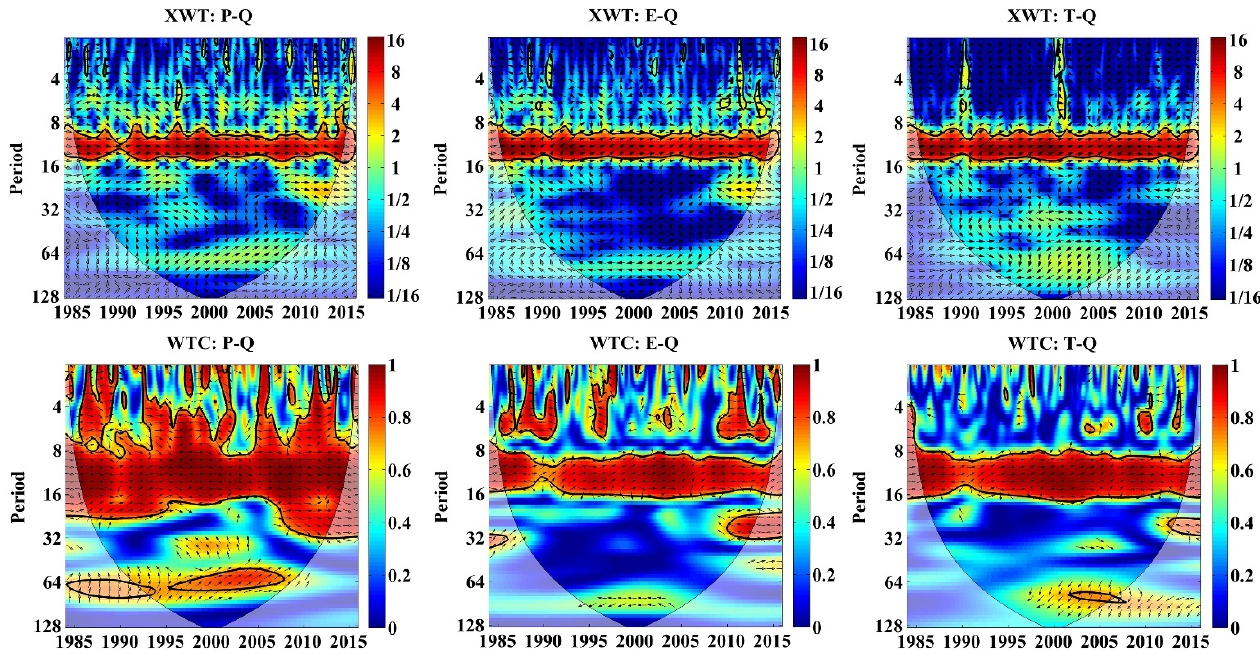
Figure 13. cross wavelet spectra and wavelet coherence spectra of monthly rainfall, temperature and evaporation with runoff in the Yinjiang River watershed from 1984 to 2015, respectively. The thick black contour designates the 5% significance level against red noise and the cone of influence (COI) where edge effects might distort the picture is shown as a lighter shade. Arrows denote relative phase difference: The arrows from left to right indicate that the influencing factors and runoff are in the same phase, which implies a positive correlation; the arrows from right to left indicate an inverse phase, which implies a negative correlation; the downward arrows indicate that the influence factor is 90° ahead of the runoff change and the upward arrows indicate that the influence factor is 90° lagging the runoff.